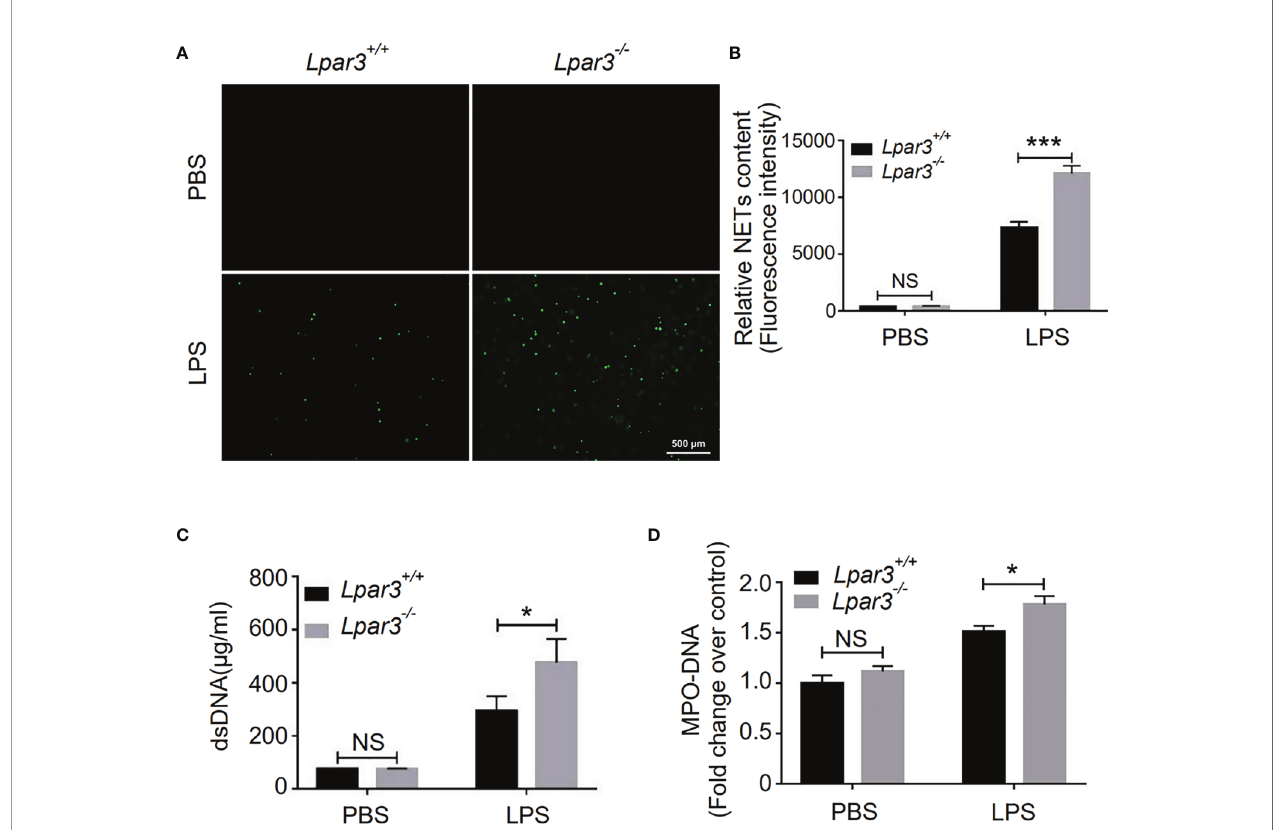
FIGURE 3 | LPA 3 de fi ciency induces excessive NETs in mice with sepsis. (A, B) Sytox-green staining of NETs induced by the plasma from septic mice. Plasma from Lpar3 -/- septic mice induced more NETs than WT controls (n = 8 for each group); Bar = 500 m m. (C) The circulating level of dsDNA in the mice after LPS injection. The level of dsDNA was much higher in the plasma of Lpar3 -/- septic mice than in that of WT controls (n = 6 for Lpar3 +/+ or Lpar3 -/- control, n = 9 for Lpar3 +/+ LPS, n = 7 for Lpar3 -/- LPS) (D) The circulating level of MPO-DNA complexes in the mice after LPS injection. The level of MPO-DNA complexes was much higher in the plasma of Lpar3 -/- sepsis mice than in that of WT controls (n =10 for each group); *P < 0.05, ***P < 0.0001. NS, no signi fi cance. LPA 3 , lysophosphatidic acid receptor 3; WT, wild-type; PBS phosphate-buffered saline; LPS, lipopolysaccharide; H&E, hematoxylin and eosin; NETs, neutrophil extracellular